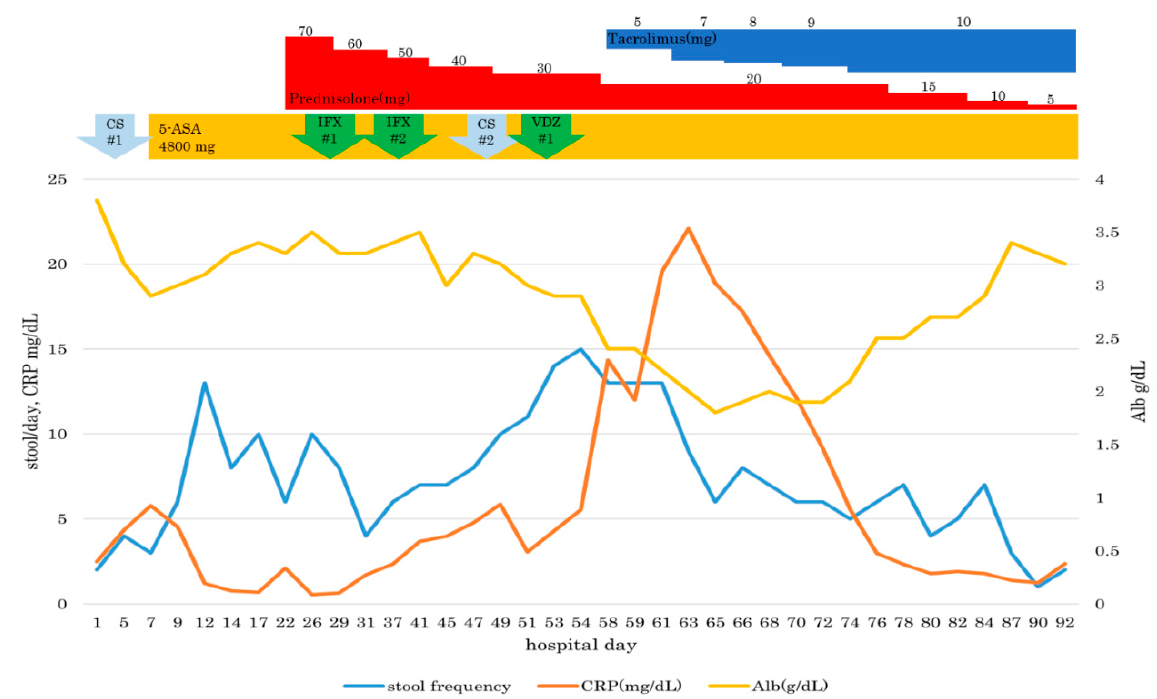
Figure 4. Clinical course until discharge.